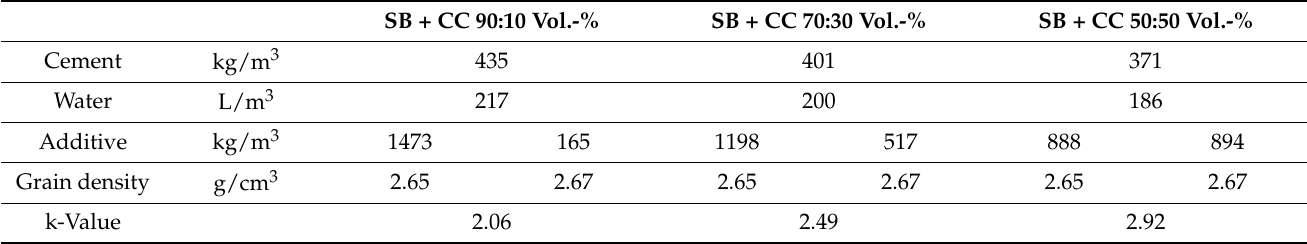
Table 3. Formulations for concrete of strength class C 25/30 with secondary m-sand substitutes: broken brick material.